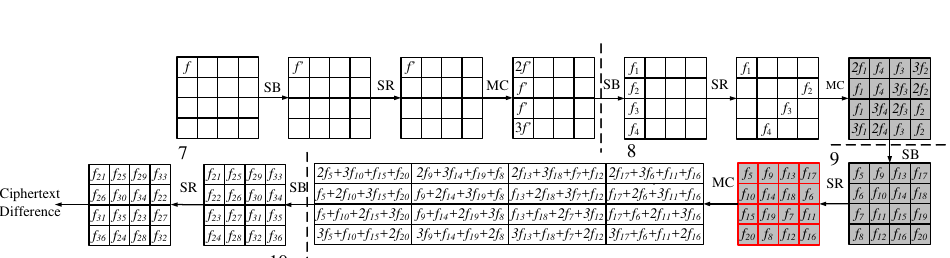
Figure 1: Fault propagation in impossible differential fault attack on AES and formation of the IDFA property (marked in red). None of the variables in this state differential can assume the value 0 for the correct key